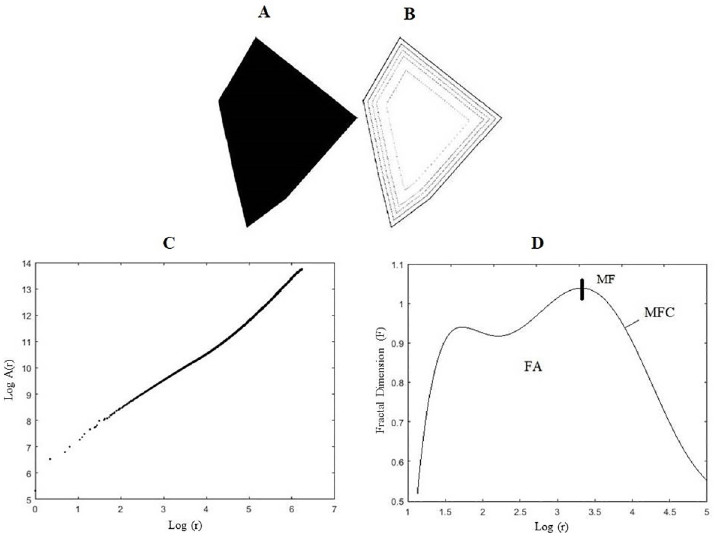
Fig 2. (A) Image of a polygon; (B) dilated contours; (C) Logarithmic function of the areas of exact dilation radius; (D) Multiscale Fractal Dimension of the analysed image, with Maximum Fractal Value (MF), Multiscale Fractal Curve (MFC), Fractal area